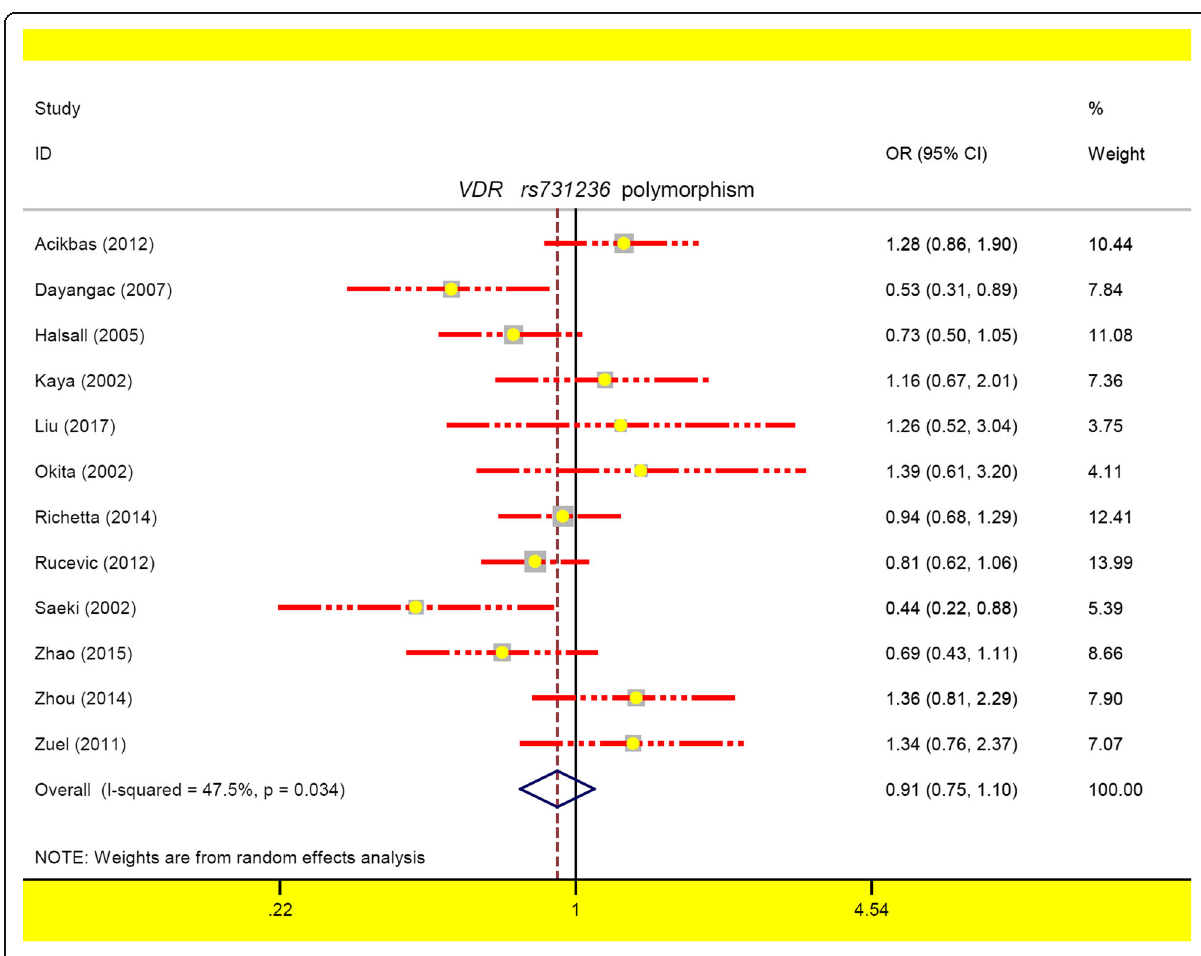
Fig. 5 The forest plot for VDR rs731236 polymorphism under the allele